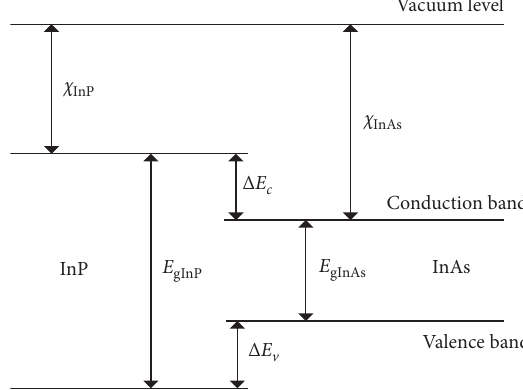
Figure 6: The band diagram of the InP/InAs